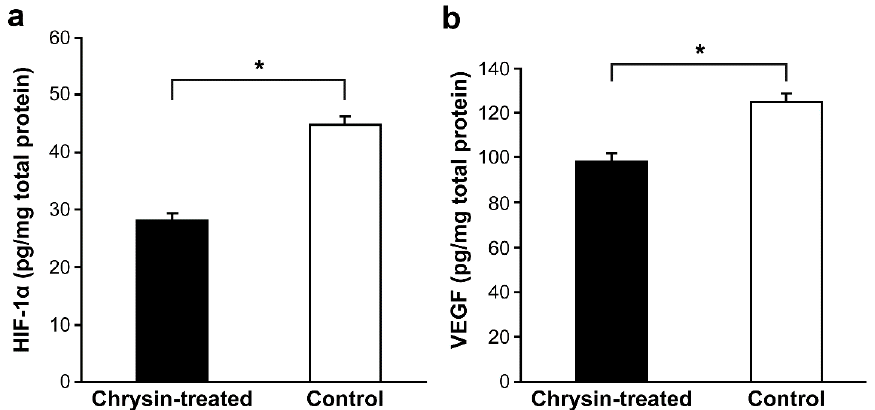
Figure 4. Concentrations of hypoxia inducible factor (HIF)-1 α and vascular endothelial growth factor (VEGF) in the retina / choroid complex of the chrysin-treated and control groups. HIF-1 α ( a ) and VEGF ( b ) protein levels were measured using enzyme-linked immunosorbent assays and normalized to the total protein concentration. The concentrations of both proteins were significantly lower in the chrysin-treated group than in the control group ( n = 15 eyes / group; * p < 0.001, Mann-Whitney U tests). Error bars indicate the standard error. HIF-1 α , hypoxia inducible factor-1 alpha; VEGF, vascular endothelial growth factor.